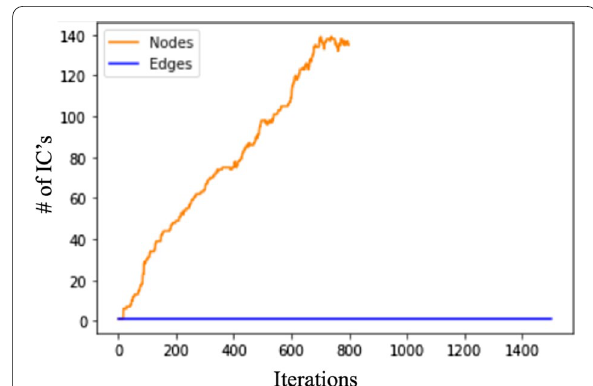
Fig. 14 Evolution of the Isolated components using the Multimodal Hubs removal strategy